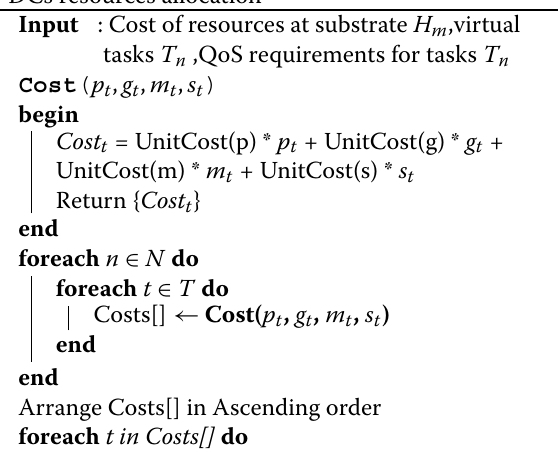
Algorithm 2: Adaption of Multi-Site in [18] for MEC- DCs resources